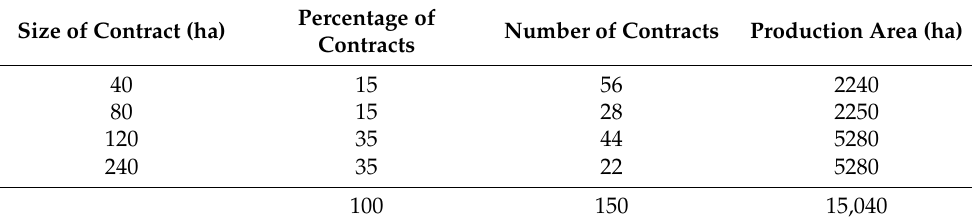
Table 1. Assumed distribution of feedstock contracts for 0.5 bale/min biorefinery. Percentage of Number of Contracts Production Area (ha) Size of Contract (ha) Contracts 40 15 56 2240 80 15 28 2250 120 35 44 5280 240 35 22 5280 100 150